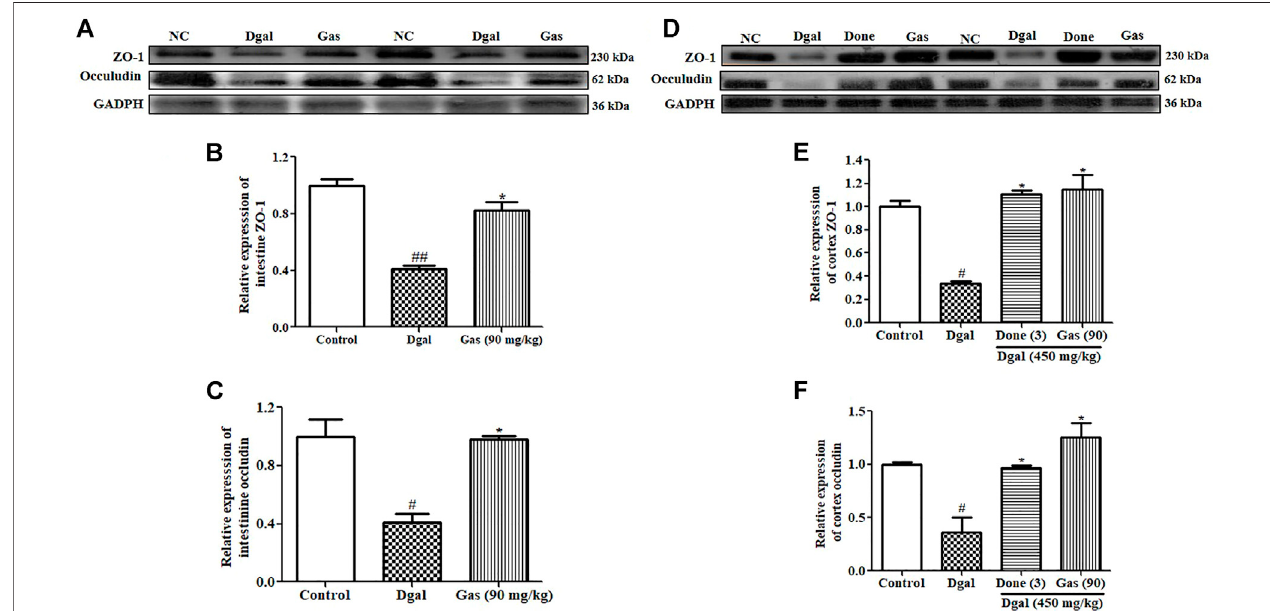
FIGURE 6 | Gas upholds the integrity of the intestinal barrier and BBB. (A) Western blot analysis of the small intestine ZO-1 and occludin. (B) and (C) represent digitalized Western blot results of ZO-1 and occludin in the small intestine. (D) Western blot analysis of the cerebral cortex ZO-1 and occludin. (E) and (F) represent digitalized Western blot results of the cerebral cortex ZO-1 and occludin. Sample number of each group is three, and the data are presented as means ± SEM. # and ## indicate signi fi cant differences at p < 0.05 and p < 0.01 compared with those of the normal control, respectively; * indicates signi fi cant difference at p < 0.05 compared with that in the Dgal group.